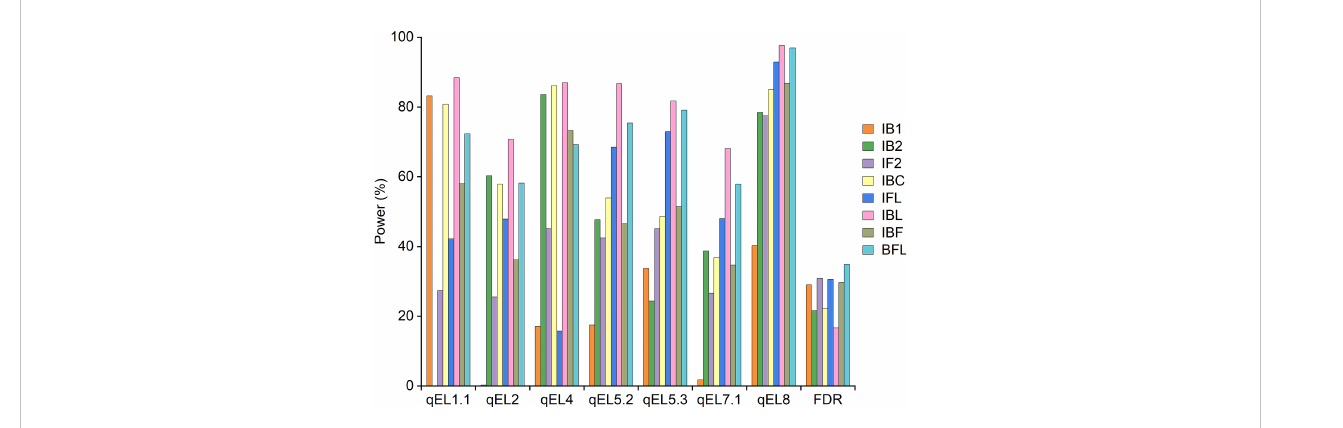
FIGURE 3 QTL detection power from individual and combined mappings in simulation experiment